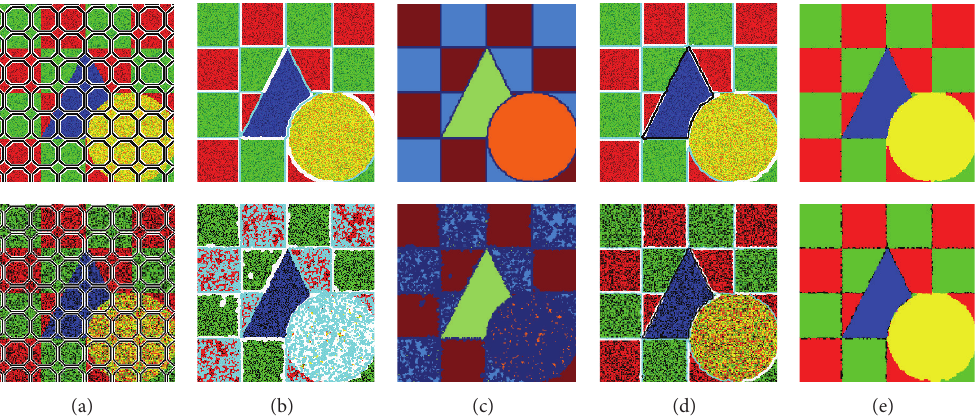
Figure 10: Results for a synthetic image added with multiplicative noise with deviations 0.1, 1, respectively. (a) Original noisy images; (b) the final contours of the FMLSM model; (c) the segmentation results of the FMLSM model labeled with different colors; (d) the final contours of the proposed model; (e) the segmentation results of the proposed model labeled with different colors.